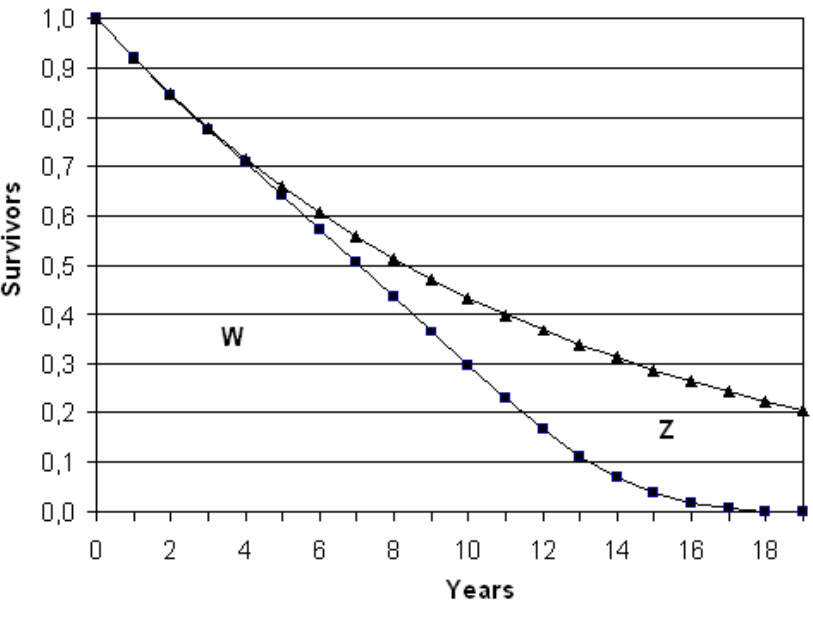
FIGURE 4. Life table of Puffinus tenuirostris (MF) with ( ■ ) and without ( ▲ ) intrinsic mortality. With intermediate extrinsic mortality area Z is of intermediate